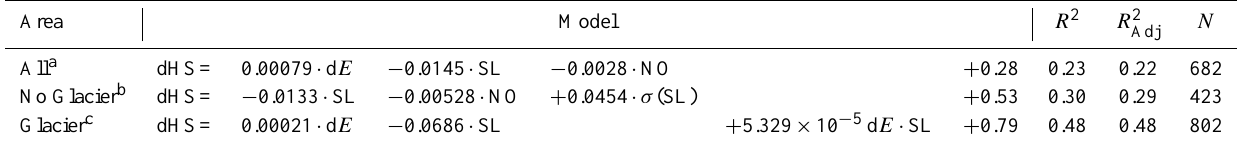
Area Model R 2 R 2